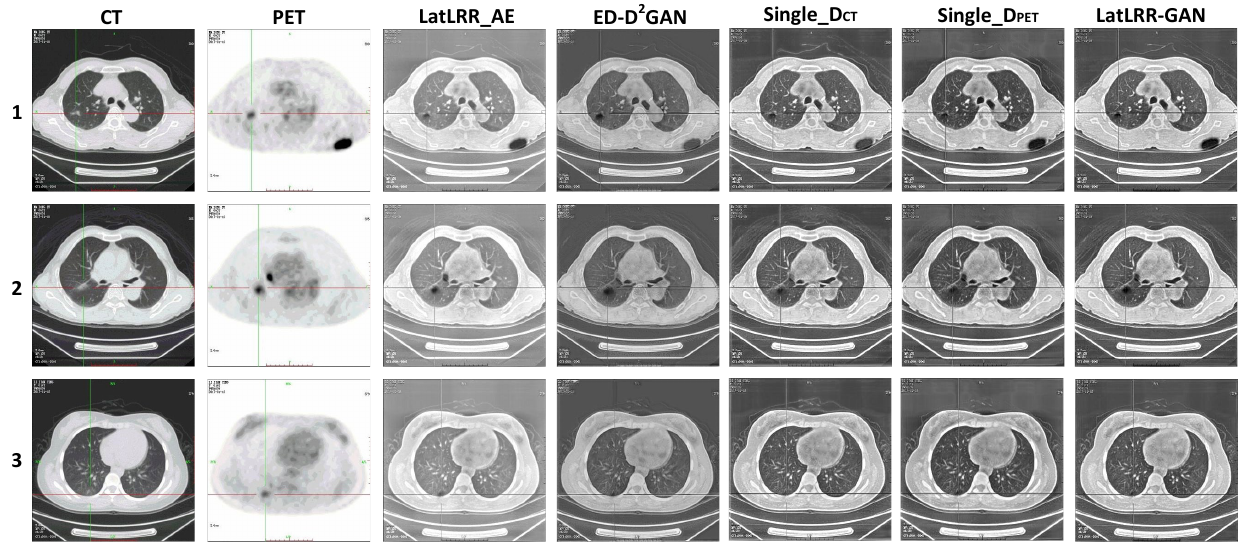
Figure 7. The fusion results of CT lung window images and PET images about the ablation experiments. Method 1: LatLRR_AE; Method 2: ED-D 2 GAN; Method 3: Single_D CT ; Method 4: Single_D PET ; Method 5: LatLRR-GAN. Table 3. The fused images’ evaluation metric results of CT lung window images and PET images about the ablation experiments. Method 1: LatLRR_AE; Method 2: ED-D 2 GAN; Method 3: Single_D CT ; Method 4: Single_D PET ; Method 5: LatLRR-GAN. The best evaluation metric values are represented in red; the second-best evaluation metric values are represented in